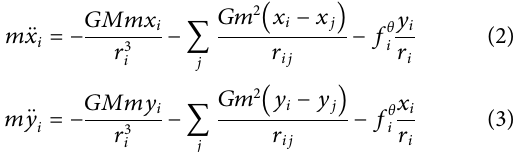
Frontiers in Astronomy and Space Sciences |